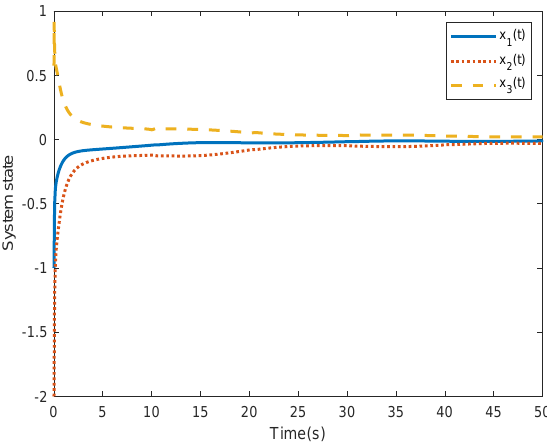
Figure 2. x ( t ) for system (1) under control law